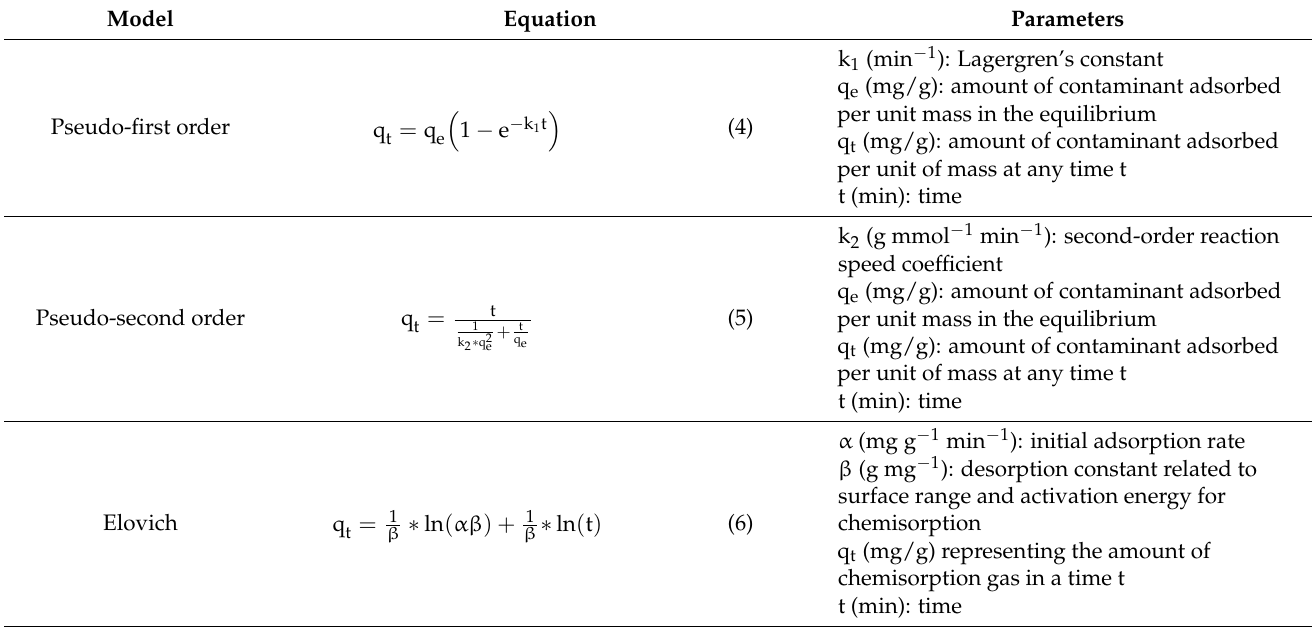
Table 1. Kinetic adsorption models